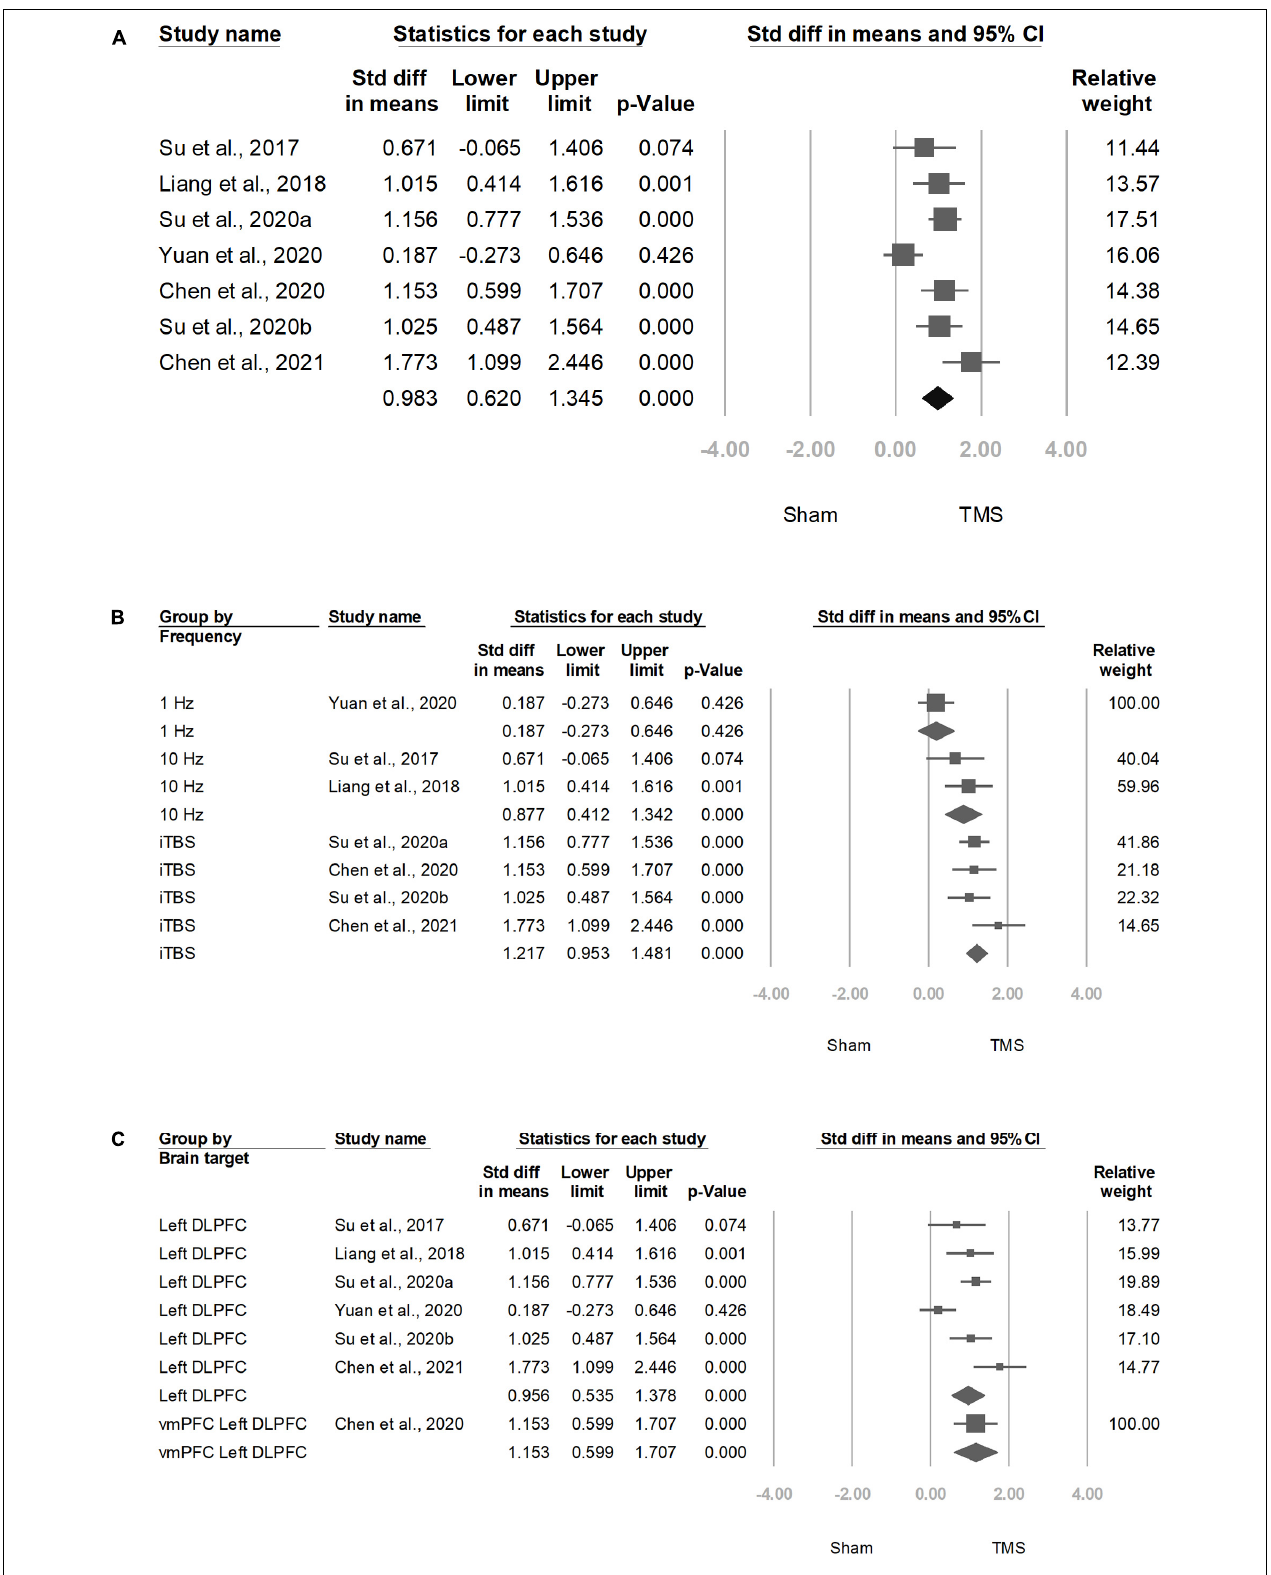
FIGURE 2 | Meta-analyses of (A) overall standardized mean difference, (B) group by frequency, and (C) group by brain target.